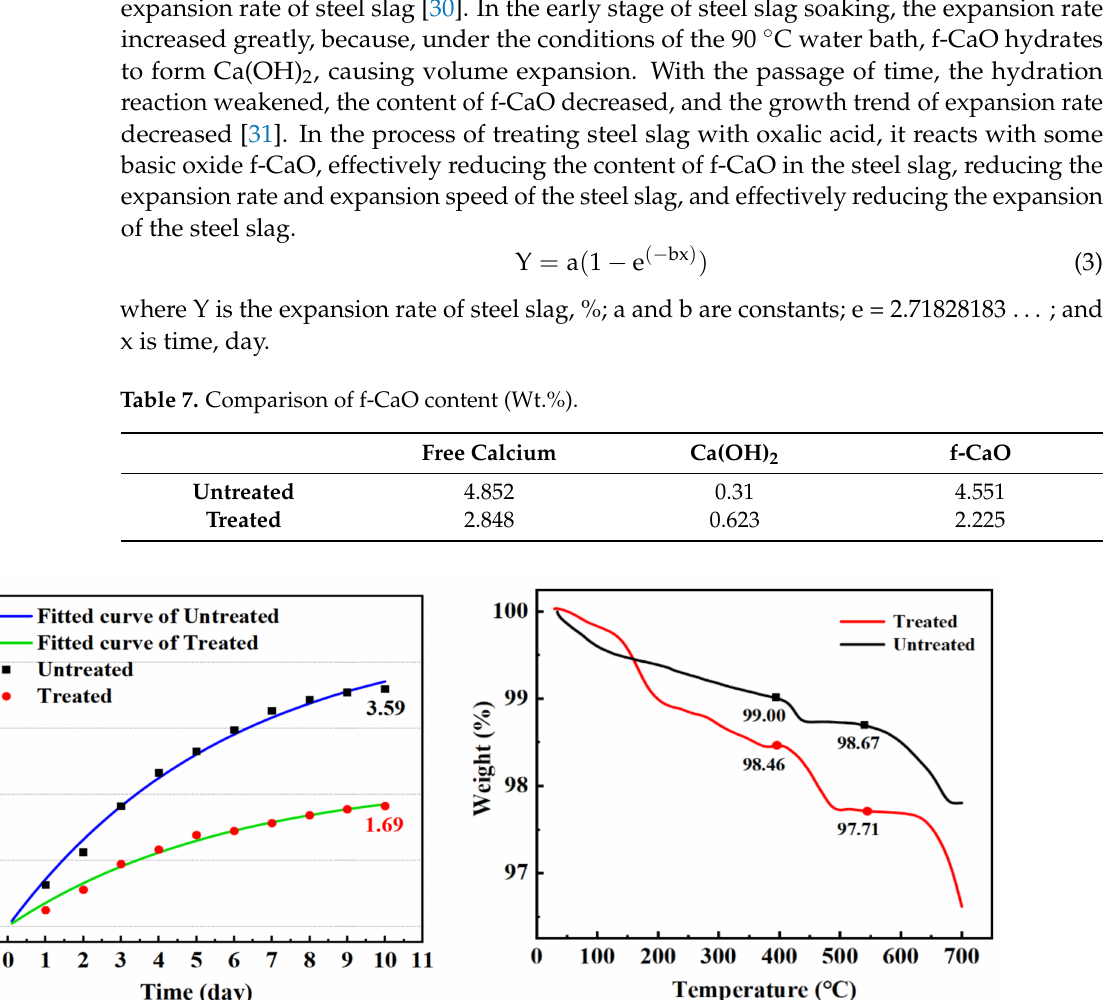
Figure 4. Comparison of steel slag expansion rate and Ca(OH) 2 mass